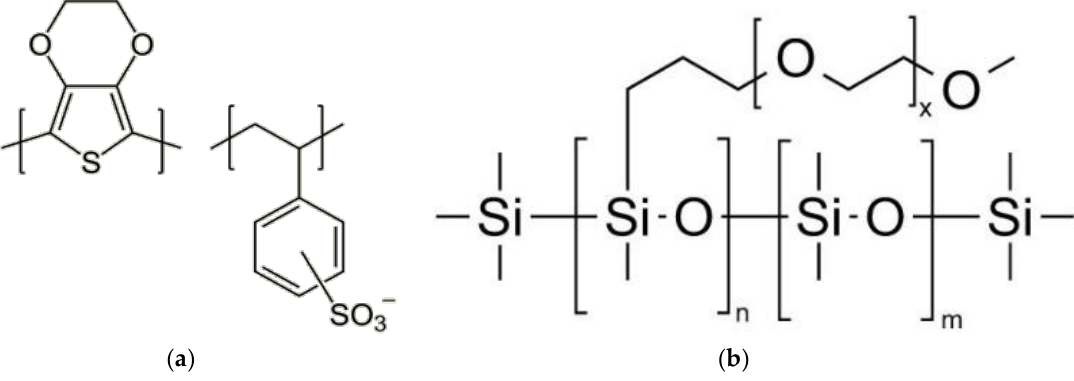
Figure 1. Chemical structure: ( a ) polystyrene sulfonate (PEDOT:PSS); ( b ) poly(dimethylsiloxane-b-ethylene oxide) (PDMS-b-PEO).